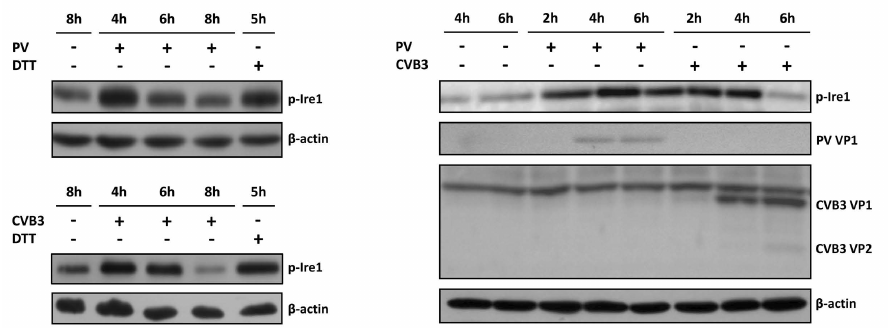
Figure 1. Ire1 phosphorylation in enterovirus-infected cells as revealed by Western blot analysis with anti-p-Ire1 antibodies. ( A ) Phosphorylated Ire1 and total β -actin levels in HeLa cells infected with PV type I Mahoney. ( B ) The same for HeLa cells infected with CVB3. Representative results of at least three independent experiments are shown. ( C ) Accumulation of viral proteins throughout the infection cycle of PV and CVB3 in HeLa